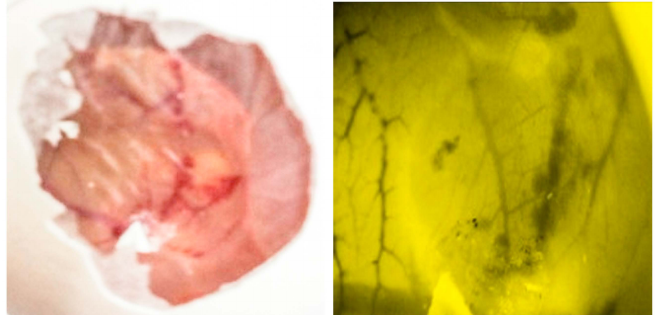
Figure 6. Macroscopic and microscopic images of chorioallantoic membrane (CAM) following inoculation with 99.8% glacial acetic acid and incubation for 24 h. Note the signs of hemorrhages, ghost vessels, and neoangiogenesis on the CAM surface. The embryo died after 24 h of